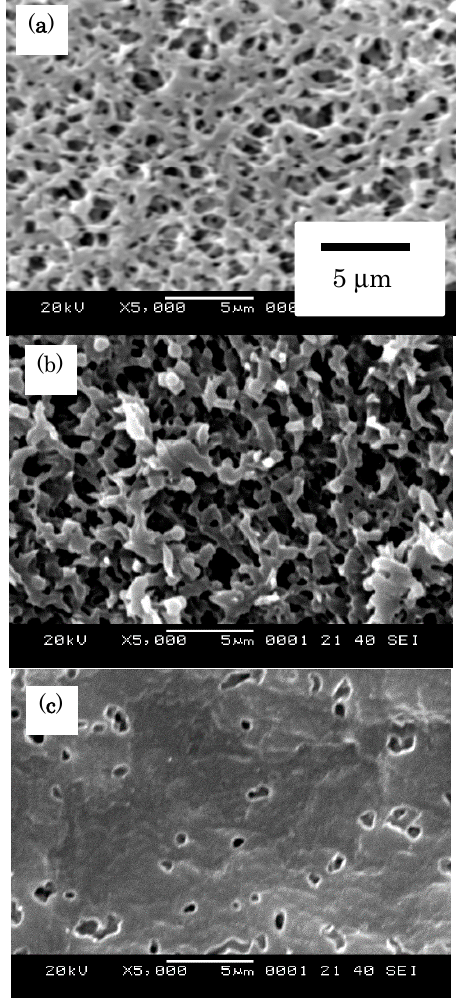
Figure 1. SEM micrographs of surface of St grafted porous PVDF membrane: ( a ) PVDF substrate membrane, ( b ) St-grafted PVDF (GD 96%), ( c ) St-grafted PVDF (after heat compression treatment), respectively.